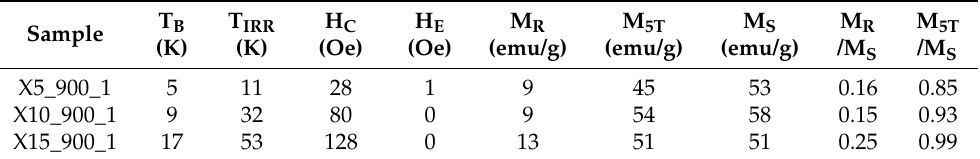
Table 2. Magnetic parameters for the 5 wt%, 10 wt% and 15 wt% CuFe 2 O 4 -SiO 2 nanocomposite xerogel samples. Relevant parameters are indicated as T B (blocking temperature), T IRR (irreversibility temperature), H C (coercivity), H E (exchange bias), M R (remanent magnetization, M 5T (maximum magnetization, M S (saturation magnetization). Hysteresis loops were recorded at 5 K. Values were determined according to what was reported in the Materials and Methods section.